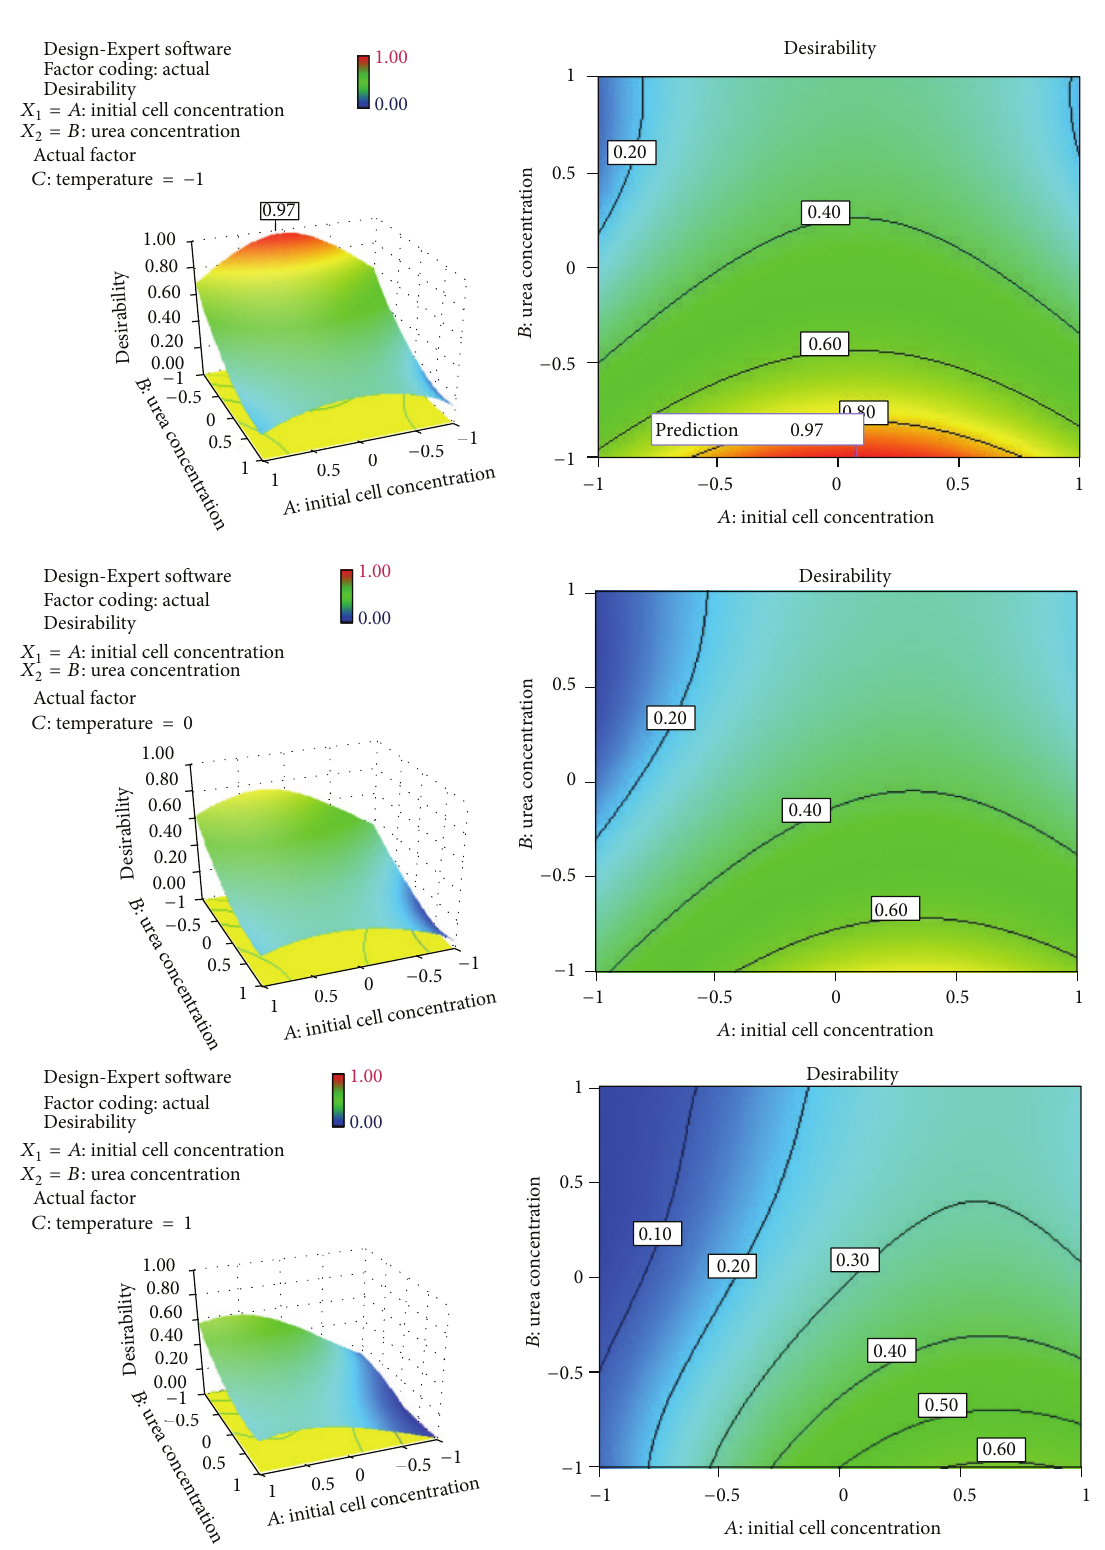
Figure 10: Desirability variation at different levels of the